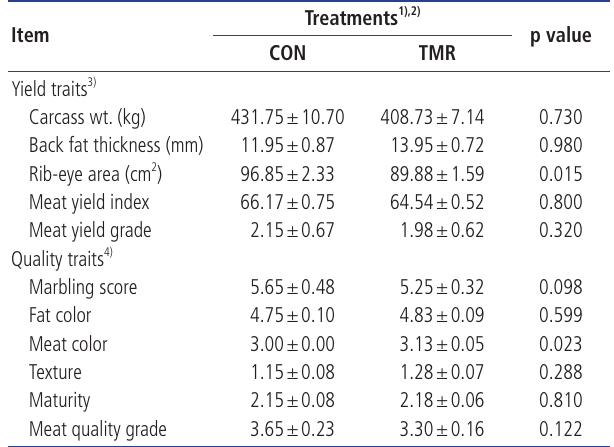
Table 6. Effect of feeding system on carcass yield and quality traits of Hanwoo steers